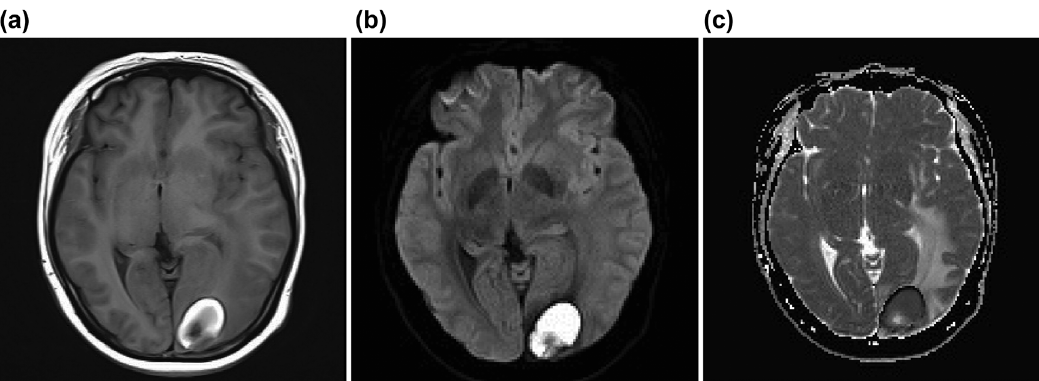
Figure 1: DCE - MRI, DWI, and ADC before treatment. Note: The depicted patient was male, 61 years old, with no smoking history, diagnosed with brain metastasis of squamous adenocarcinoma. ( a ) DCE - MRI image, showing a ring enhancement lesion about 4.3 cm in the right temporal lobe, with signi fi cantly low signal in the center ( where the arrow points ) ; ( b ) DWI image, showing signi fi cantly low signal in the center of the lesion, equal or high mixed signal at the edge, and equal signal in peritumor edema; ( c ) ADC image, showing accelerated di ff usion of the lesion center and unrestricted di ff usion of surrounding edema.